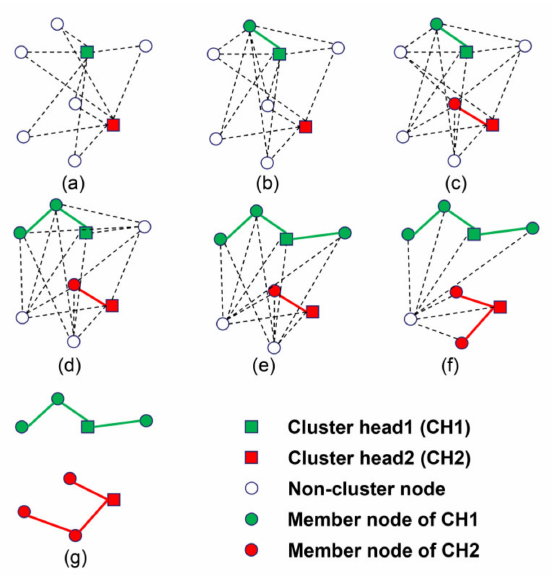
Figure 4. ( a – g ) Process of multi-start minimum spanning forest algorithm with two clusters. In the phase of multi-hop transmission between clusters, with the BS as the only starting point and the cost of Equation (16) as the edge weights, a tree network between the cluster heads can be generated. The overall topology of the network is shown in Figure 5.